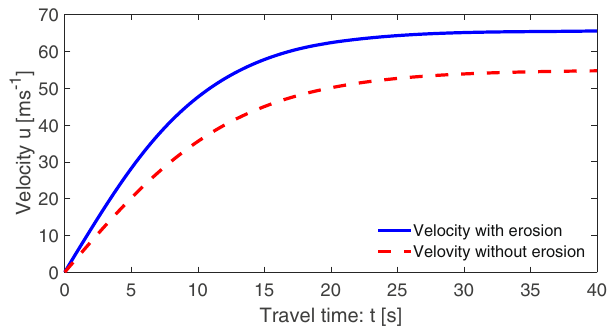
Fig. 1 Time evolution of the landslide velocity with and without erosion given by (20). Erosion enhances the landslide velocity and thus its mobility. With erosion, the steady-state velocity is higher and is reached earlier than the same without the erosion. This is due to the erosion-induced gain in momentum that increases the instantaneous velocity for which the drag takes shorter time to bring the motion to the steady-state, but